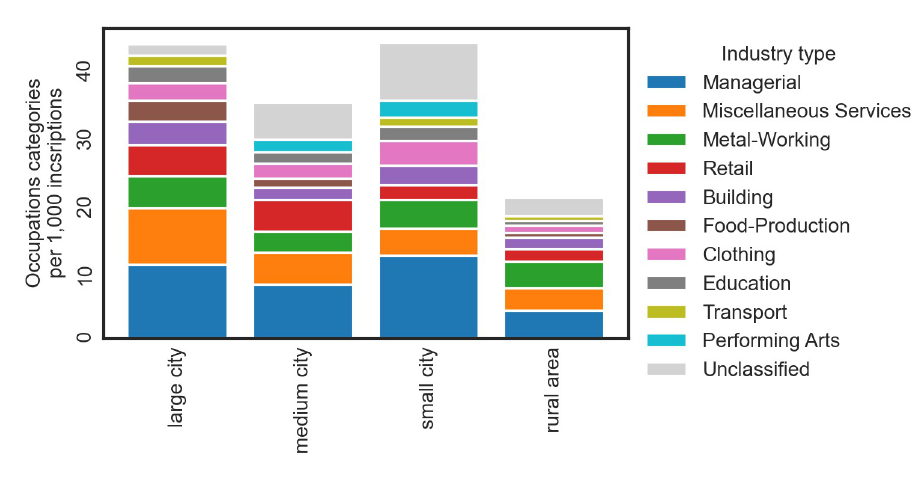
Fig 2. Occupations by industry type across urban contexts. The bars express the cumulative frequency of individual occupation types per 1,000 inscriptions.